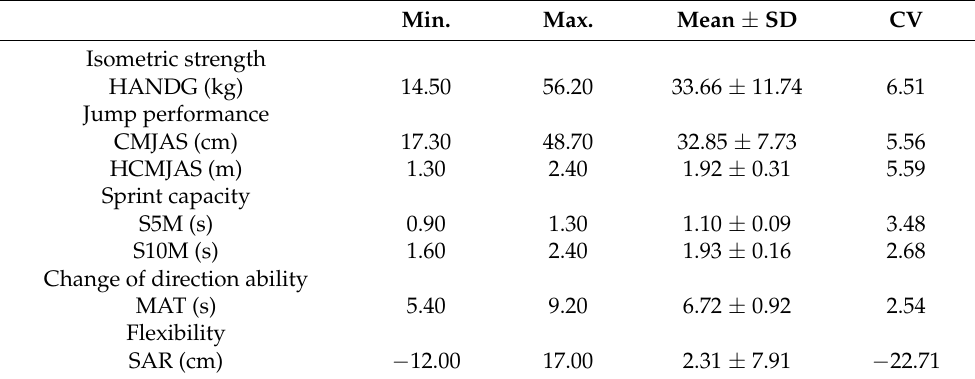
Table 2. Handgrip isometric strength, vertical jump, horizontal jump, sprint, change of direction ability, and flexibility results of all the table tennis